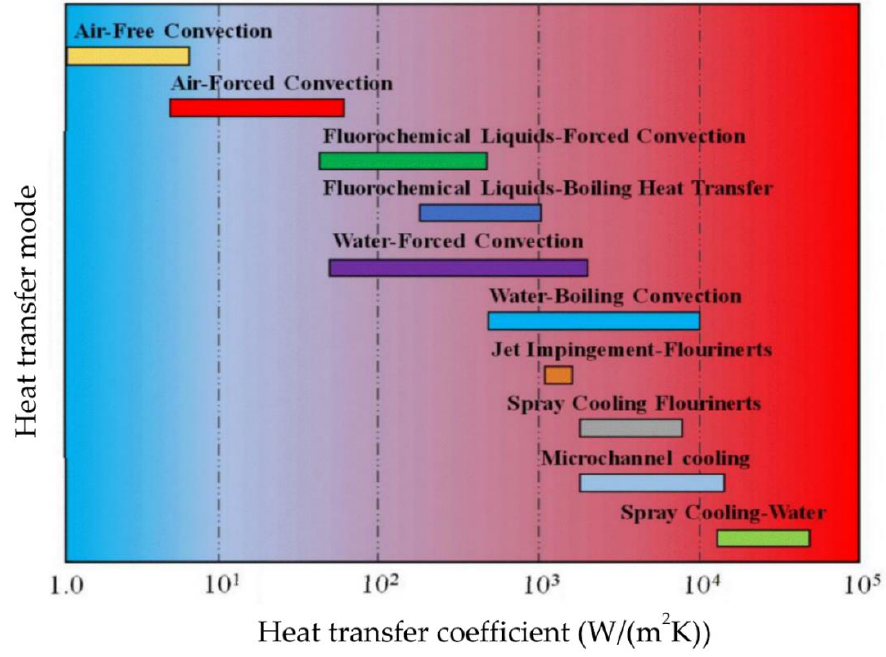
Figure 1. Cooling capacity comparison with various cooling methods. “Reprinted with permission from Ref [9] . Copyright 2015 Elsevier”.